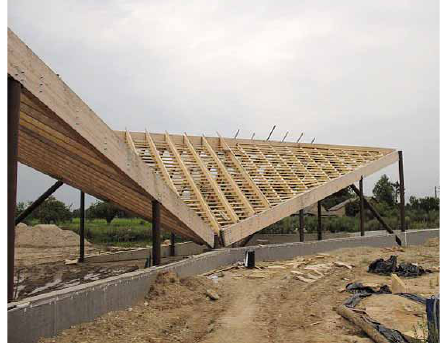
Fig. 30. Cafe building in Šeduva during construction, archit. D. Čiuta, G. Auželis, 2007